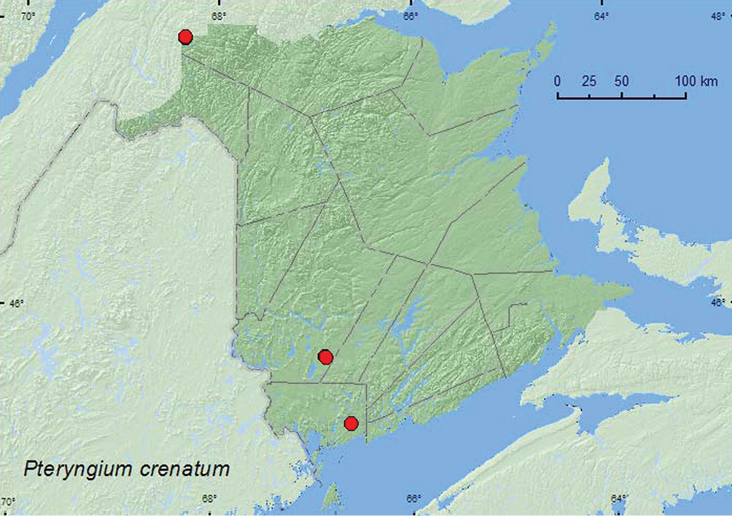
Collection localities in New Brunswick, Canada of Pteryngium crenatum.